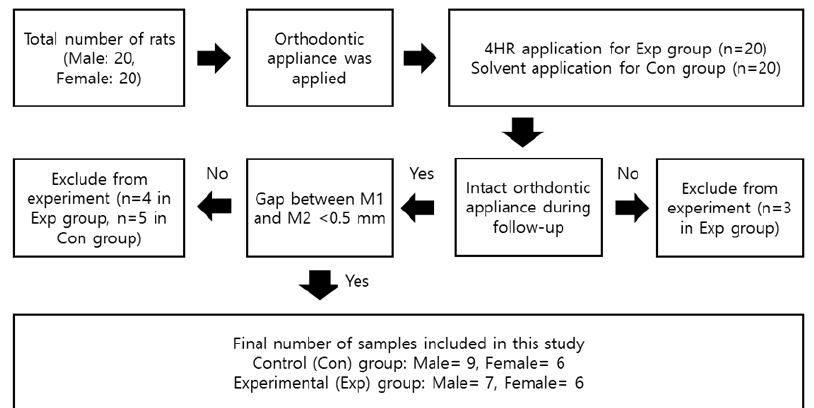
Figure 1. The flowchart for the experimental design.